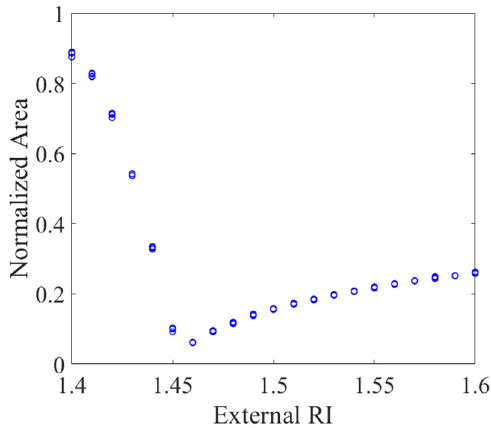
Figure 6. Ten correlation points measured with TFBG sensor for each used RI liquid.